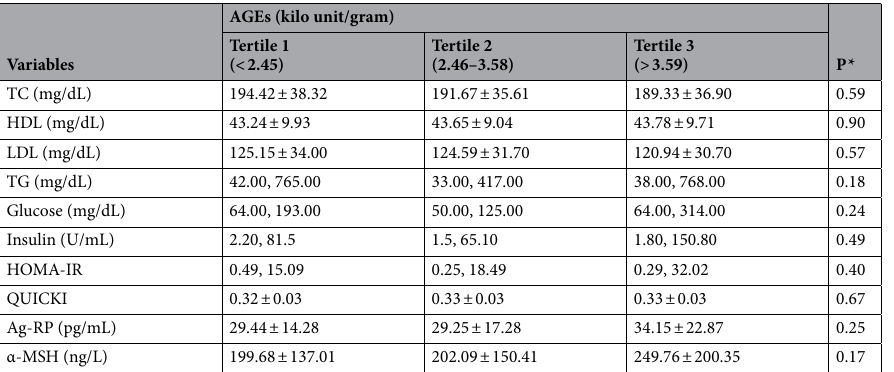
Table 2. Comparison of biochemical values in AGEs tertiles. TC Total cholesterol, HDL High density lipoprotein, LDL Low density lipoprotein, TG Triglyceride, Ag-RP Agouti related peptide, α-MSH α-Melanocyte stimulating hormone. Values are presented based on mead (SD) or median (min, max). Comparison was done using One-Way ANOVA and Kruskal–Wallis. *P values based on ANCOVA adjusted for age and sex.